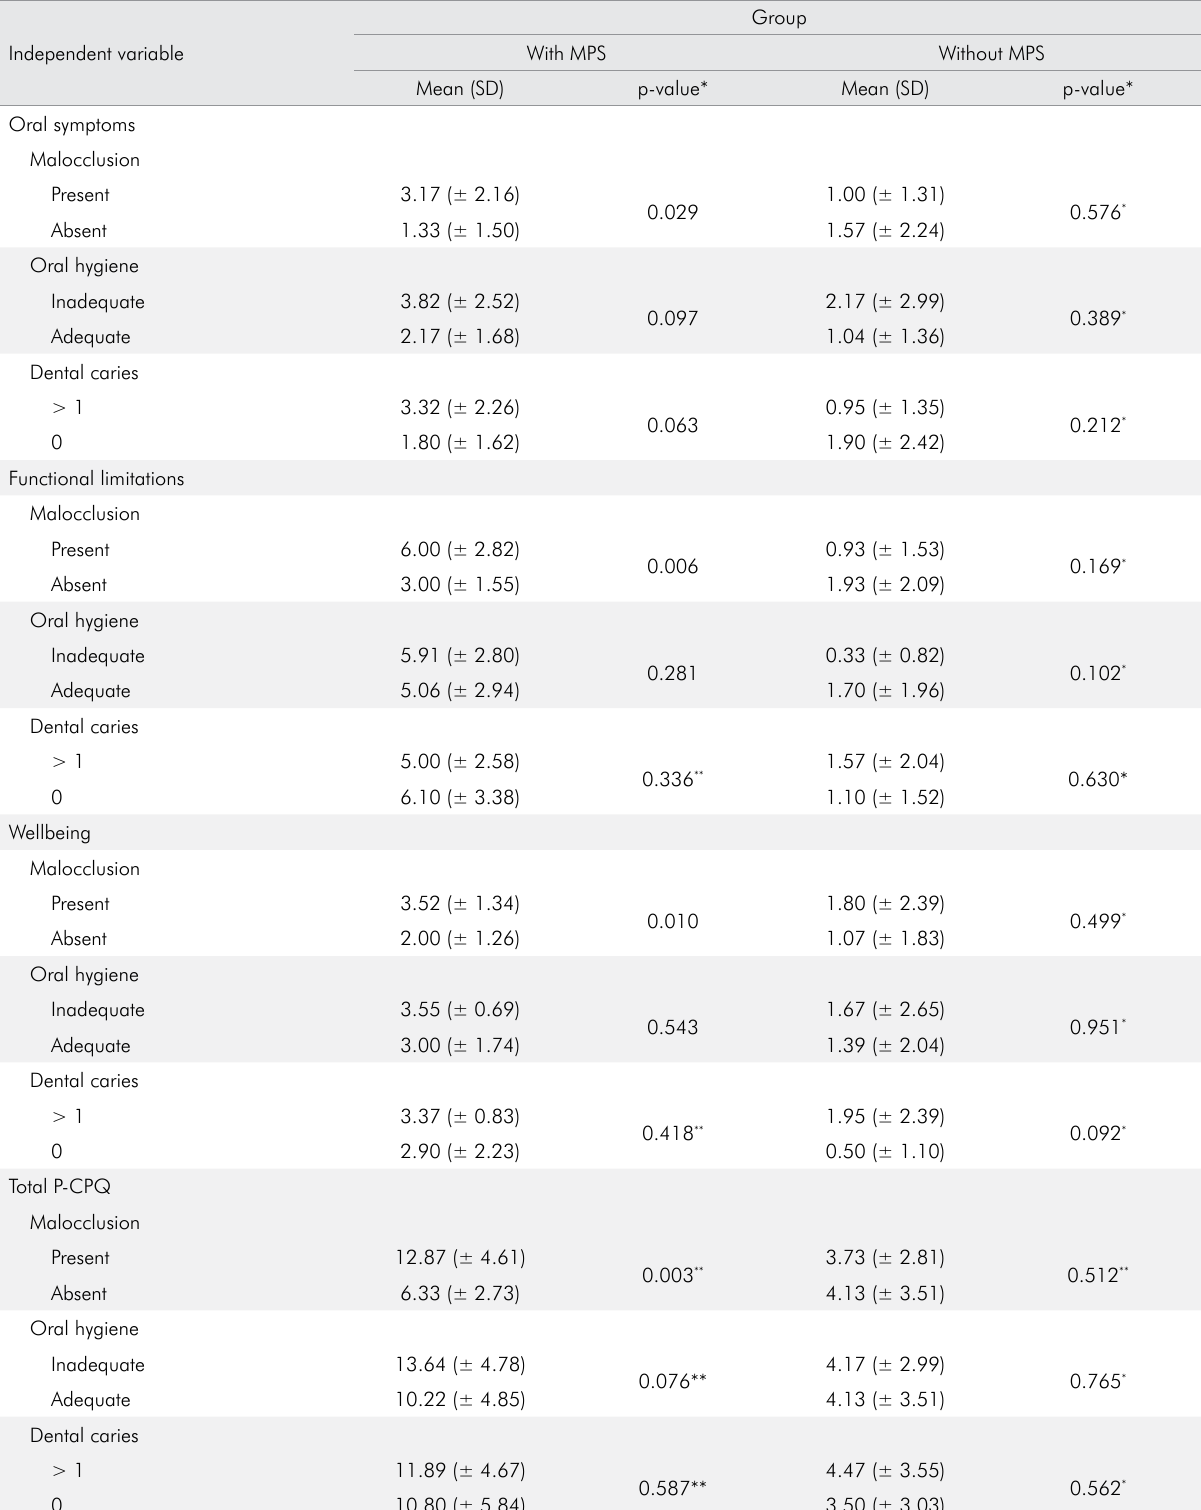
Table 3. P-CPQ scores among individuals with and without MPS according to independent variables (n = 58). Group Independent variable With MPS Without MPS Mean (SD) p-value* Mean (SD)